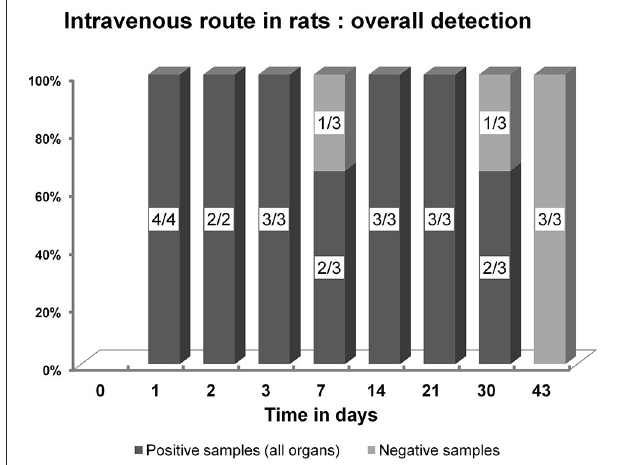
FIGURE 2 | Overall detection and persistence of Marseillevirus DNA by PCR after an intraveinous inoculation in rats, during the 43 day long experiment.